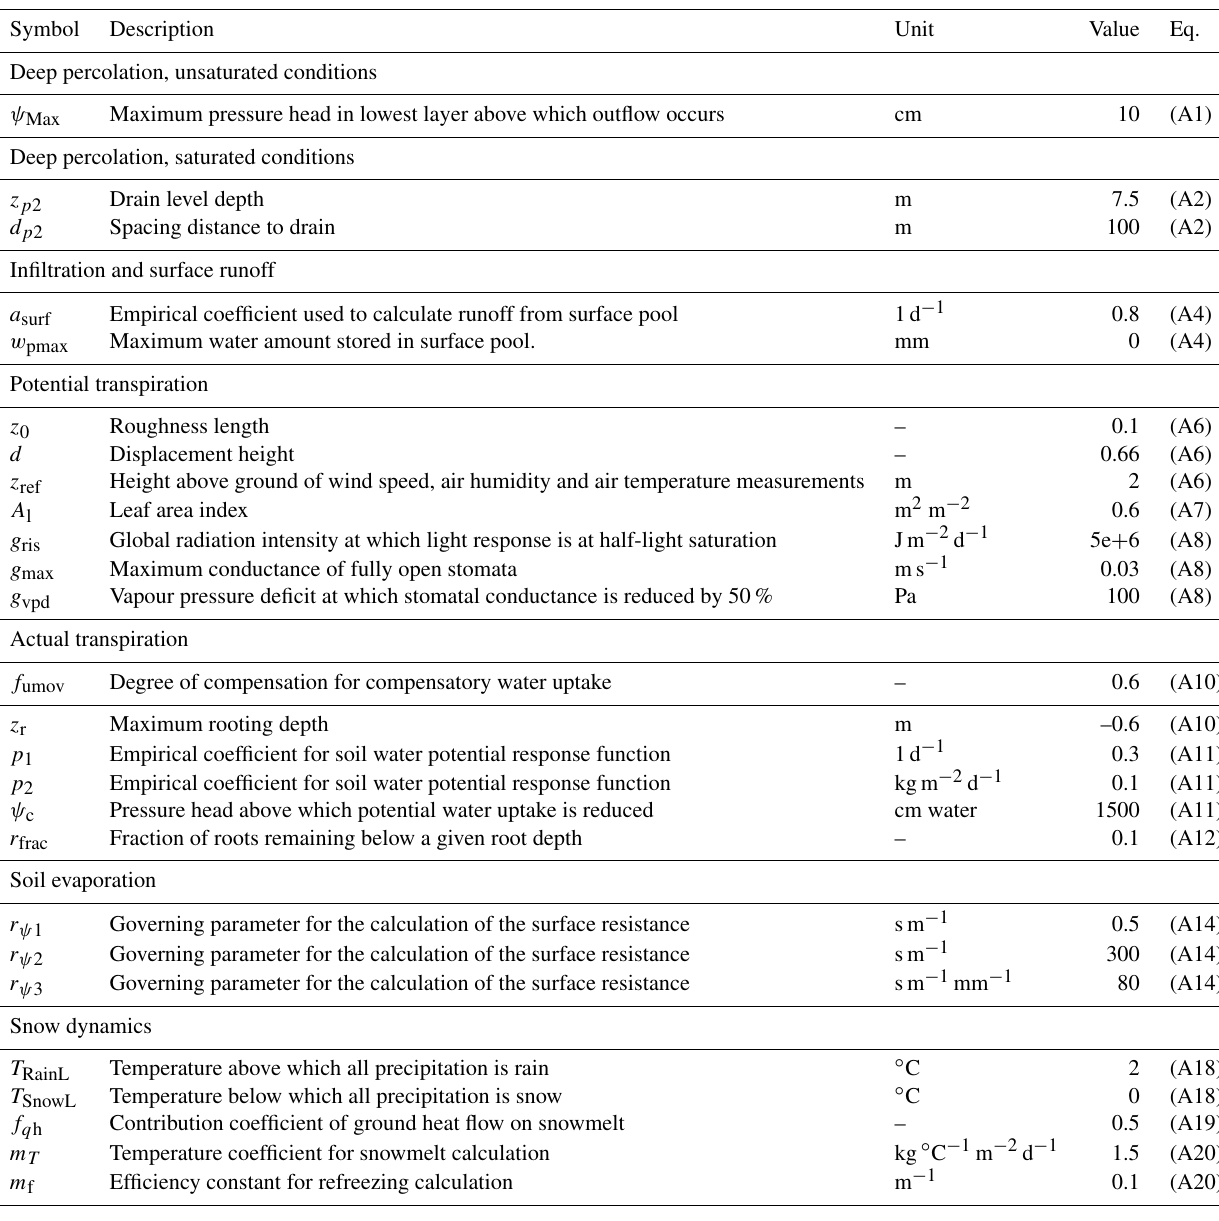
Table A2. Description of the most important parameter values used in the CoupModel set-up along with the associated equations (see Jansson and Karlberg, 2011, for more